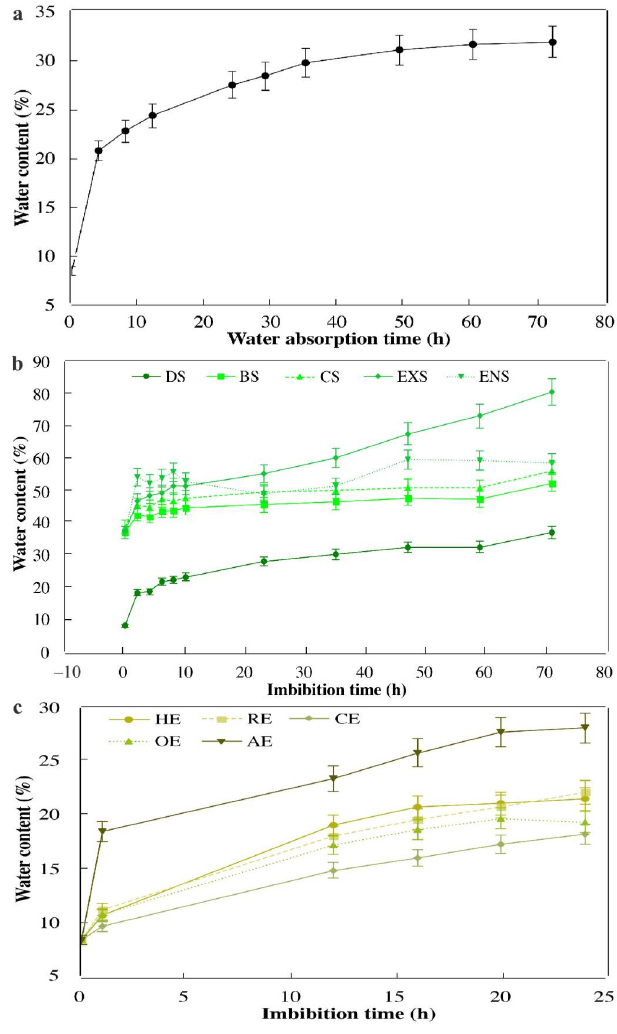
Figure 6. Variation in the water content of intact dried Chinese pistache seeds with the absorption time ( a ). Variation differences in the water content under different imbibition treatments ( b ). Varia- tion differences in the water content under different blocking treatments ( c ). DS, intact dry seeds; BS, imbibed seeds; CS, cracked seeds; EXS, exotesta-removed seeds; ENS, endotesta-removed seeds; AE, whole area of the seed exposed; OE, whole area exposed except for the hilum, raphe, and chalaza; HE, hilum exposed; RE, raphe exposed; and CE, chalaza exposed.